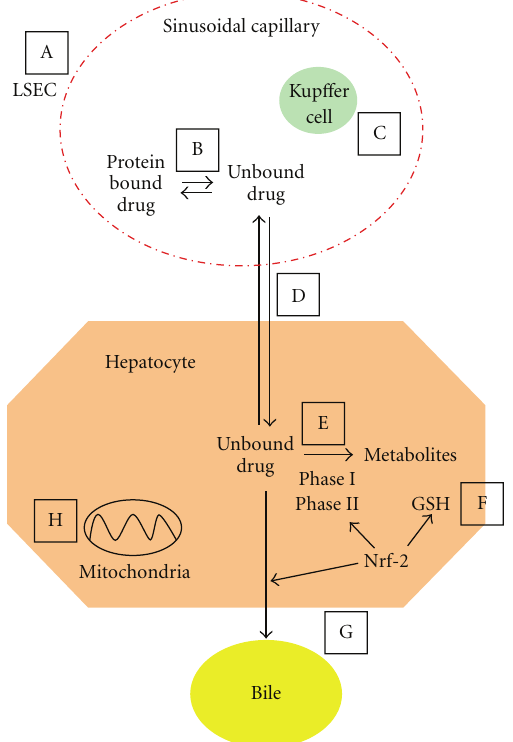
Figure 1: Hepatic pharmacology and toxicology in old age. (A) Pseudocapillarisation (thickening, defenestration, and basement membrane formation) of the liver sinusoidal endothelial cells (LSECs) may a ff ect susceptibility to drug-induced liver injury (DILI); (B) Changes in protein binding in old age a ff ect the amount of free drug available for clearance; (C) Dysregulation of Kup ff er cell activation may alter inflammatory response to DILI; (D) Pseu- docapillarisation of the LSECs, and any changes in transporters, may alter drug transfer from the blood to hepatocytes; (E) Age- related changes in hepatic metabolism a ff ect drug clearance: phase I metabolism is reduced, and changes in phase II metabolism are less well understood; (F) Reduced glutathione (GSH) in old age increases injury by toxic metabolites; (G) Expression of hepatic transporters in response to drug toxicity is poorly described in old age and a ff ects biliary excretion of drugs and their metabolites; (H) Changes in mitochondrial structure and function in old age alter response to reactive oxygen species and cell death pathways. Steps (E), (F), and (G) are regulated by nuclear factor E2-related factor 2 (Nrf-2) which has reduced hepatic expression in old age. Figure adapted from [24,